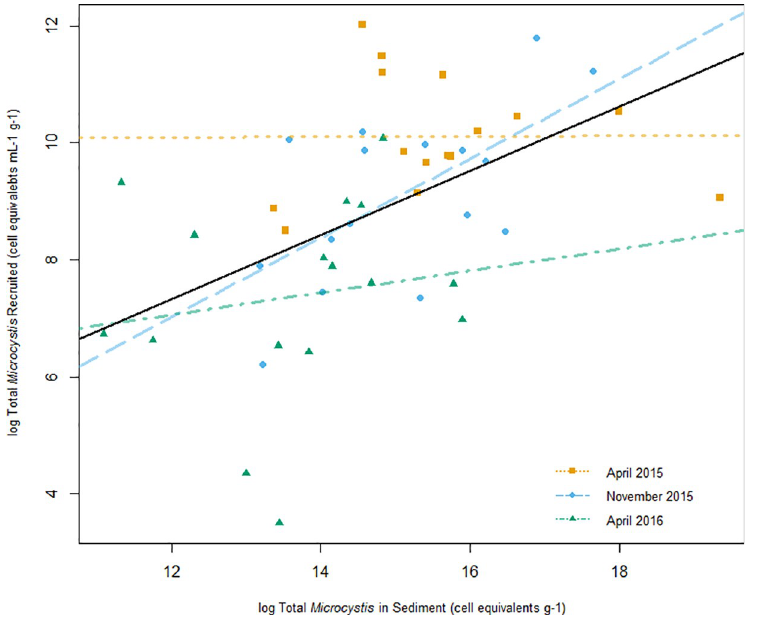
Fig 7. Microcystis vitality plotted against Microcystis abundance. The amount of total Microcystis in overlying water at t 2 (log cell equivalents mL -1 g -1 ) plotted against Microcystis sediment abundance (log cell equivalents g -1 ). Values at t 2 were used to minimize the impacts of sampling dilution and influences of growth. The plot shows simple linear models for April 2015 data (dotted line), November 2015 data (dashed line), April 2016 data (dot-dashed line), and for overall data (solid line).